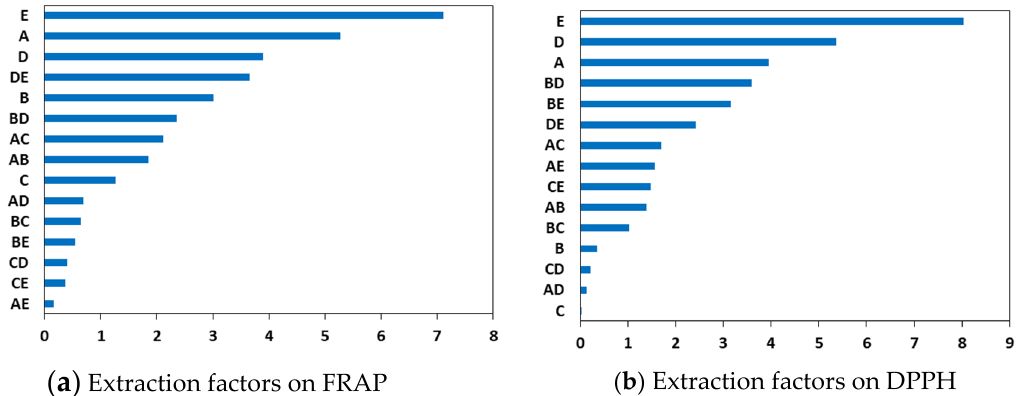
Figure 1. The main effects of ingredients on specified responses: ( a ) extraction factor effect on ferric−reducing antioxidant power (FRAP); ( b ) extraction factor effect on 2,2−diphenyl−1−picrylhydrazyl free radical scavenging activity (DPPH); A, extraction time; B, extraction temperature; C, ultrasonic power; D, liquid-to-solid ratio; E, acetone concentration.